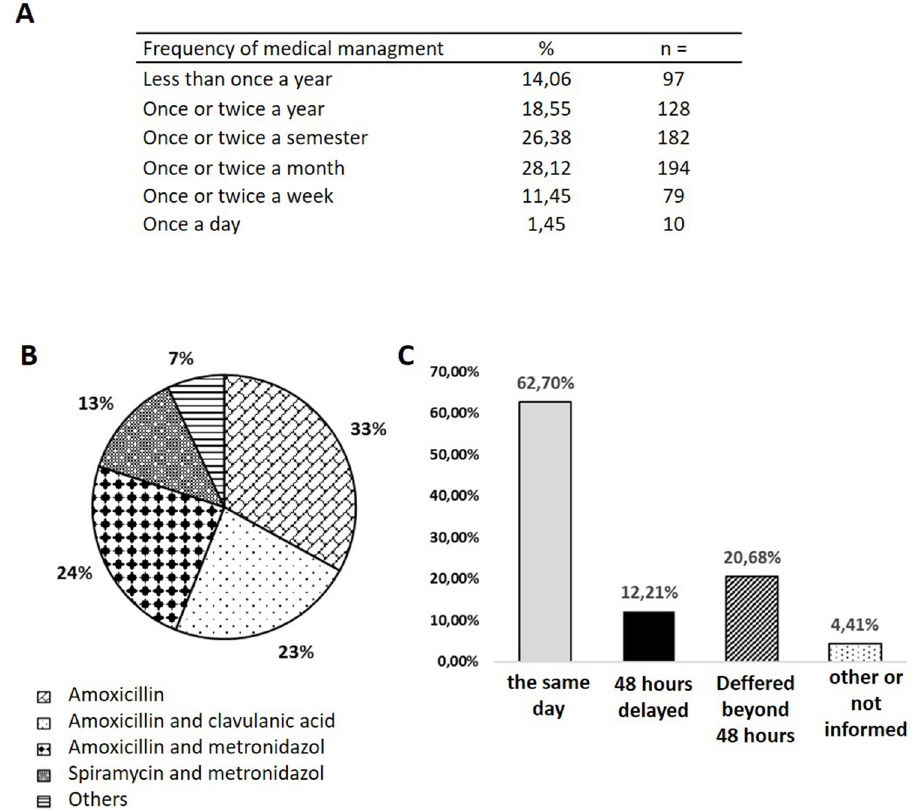
Fig. 2. Management practices for treatment of acute odontogenic cellulitis. (A) Frequency of occurrence of acute odontogenic cellulitis management in percentages and absolute value ( n ). (B) Frequency of antibiotic prescriptions in percentages (without any differentiation between fi rst line and second line treatments). (C) Surgical procedures performed and timing of procedure (in